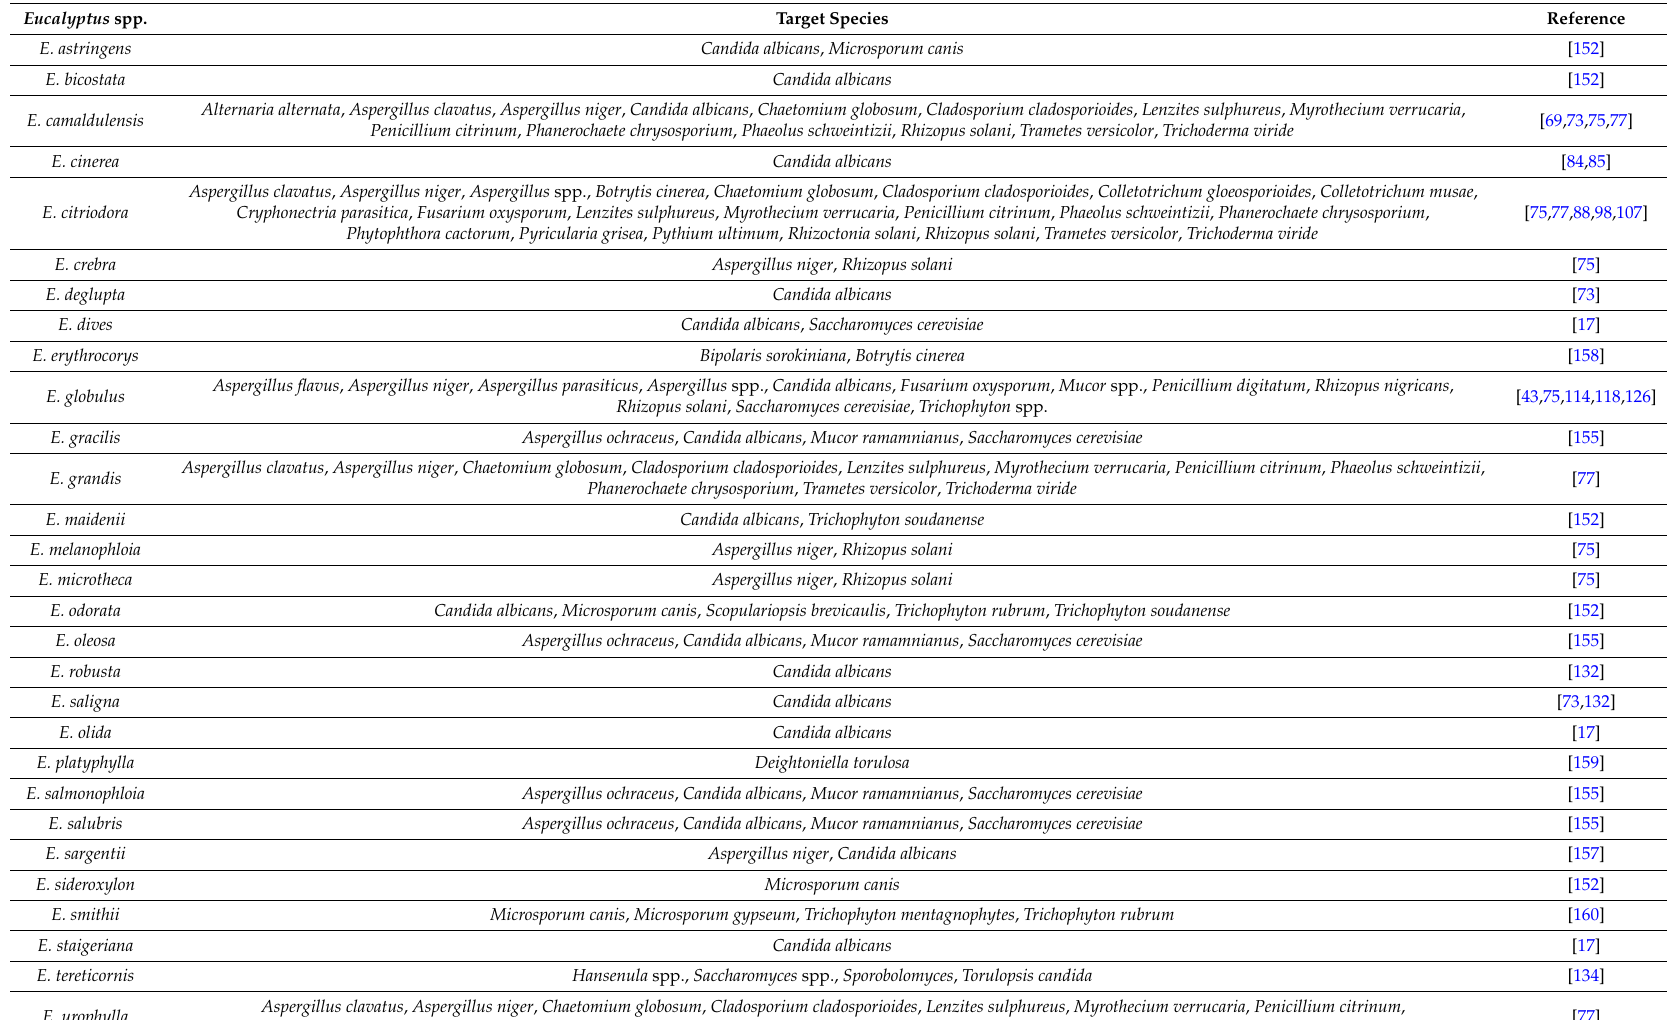
Table 3. Eucalyptus spp. essential oils with antifungal activities.